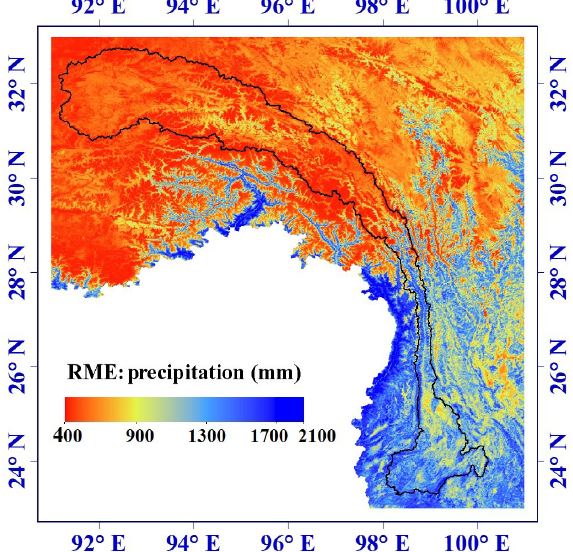
Figure 8. Average annual precipitation distribution of 2003–2012 from RME.